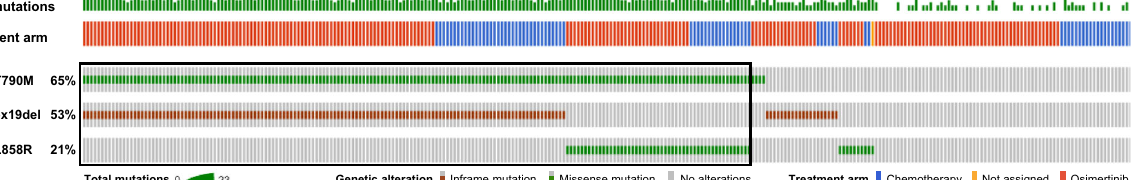
Fig. 1 Known EGFR alterations detectable in plasma cfDNA at baseline by next-generation sequencing. a Percentage of patients with detectable activating EGFR mutations, either exon 19 deletion (ex19del) or L858R, and T790M. Both treatment arms, osimertinib and platinum ‐ based therapy plus pemetrexed, are included in the graph. b Distribution of VAF of EGFR ex19del or L858R and T790M. Black line represents median VAF. c Oncoprint showing concurrent EGFR alterations detected in 289 AURA3 patients. A total number of detectable alterations per patient is shown in a histogram at the top of the oncoprint. Patients positive for both activating EGFR mutation and T790M have been selected for further analysis ( n = 184, black